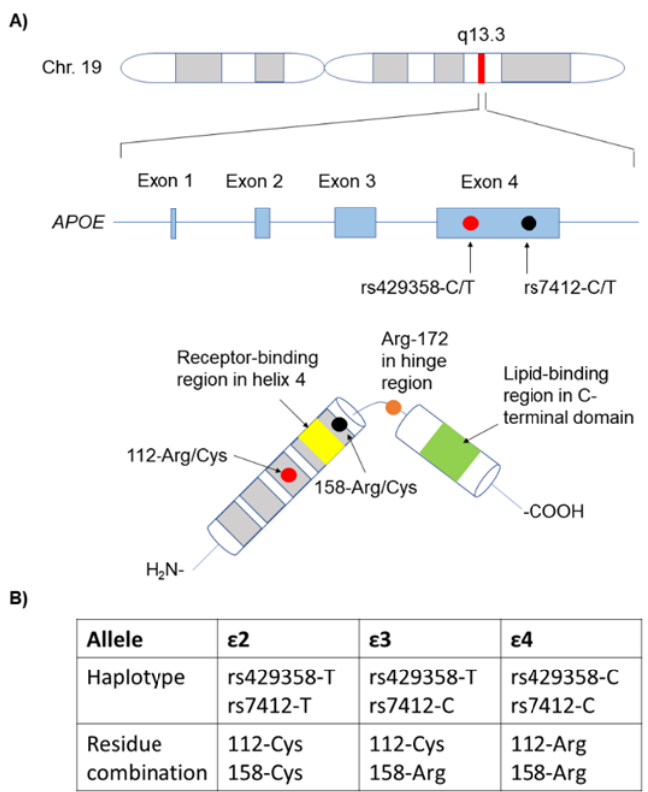
Figure 1. Polymorphisms underlying the three main APOE variants in humans. ( A ) Chromosome location, gene structure, identity of the mutating sites in the gene, and the corresponding mutating residues in the context of the protein structure. In yellow, it is indicated as the receptor-binding region in helix 4 and, in green, it is the lipid-binding region in the C-terminal domain. Red and black dots indicate the genetic variants in APOE and their position in the genomic and protein sequences, respectively. ( B ) Table reporting the haplotypes and corresponding residue combination associated to each APOE allele.